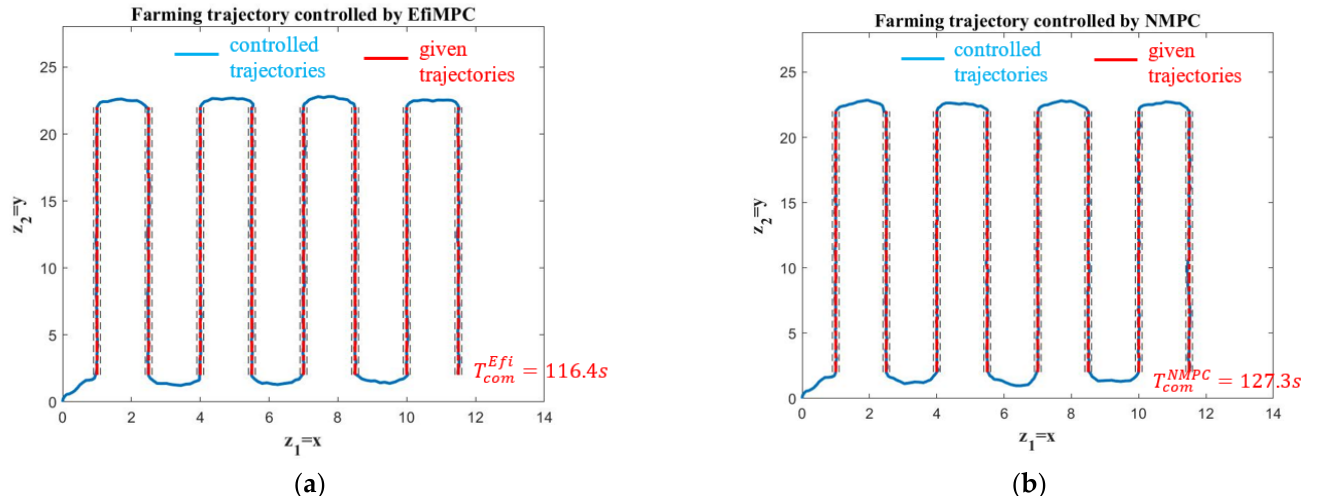
Figure 8. The working trajectories of autonomous vehicles controlled by ( a ) EfiMPC, and ( b ) NMPC.